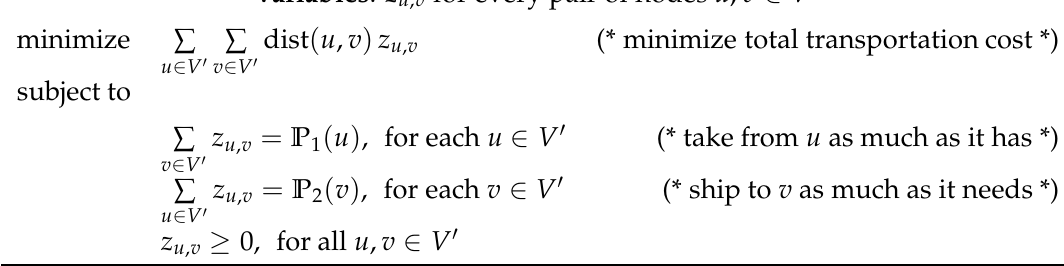
Figure 1. LP -formulation for E MD on the set of nodes by (* and *). Note that the constraints z u , v